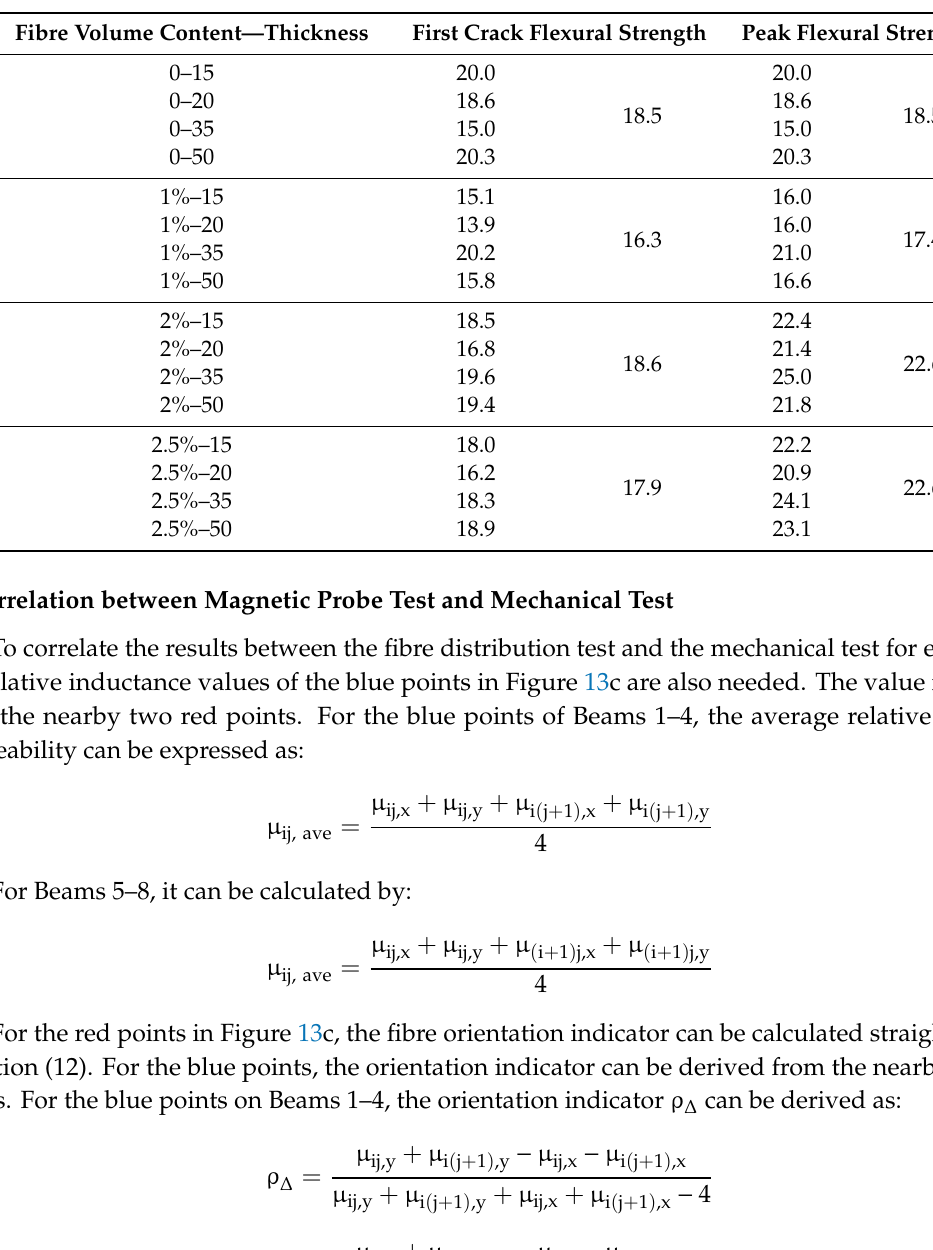
Table 9. First crack flexural strength and peak flexural strength (unit: